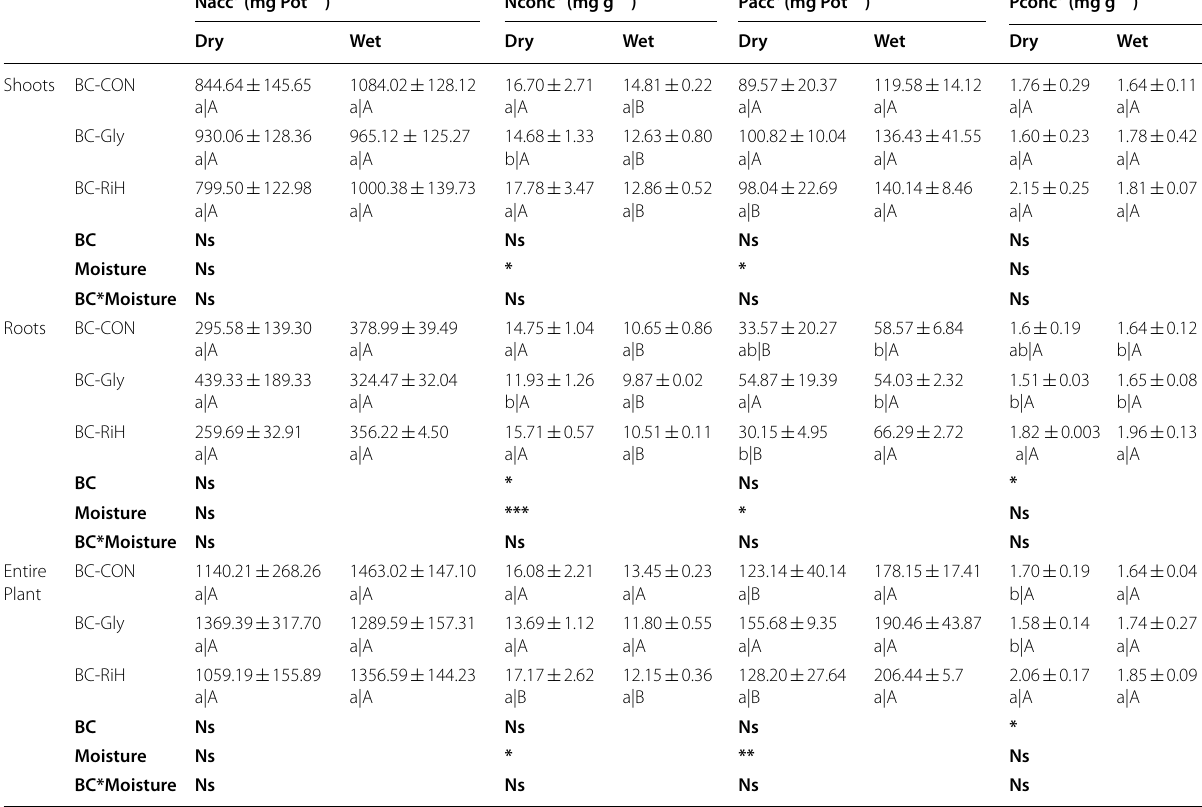
Table 3 Nitrogen and phosphorus accumulated in the plant tissues of the coconut seedlings at the end of the experiment and their respective concentrations (mean SD; n ± =